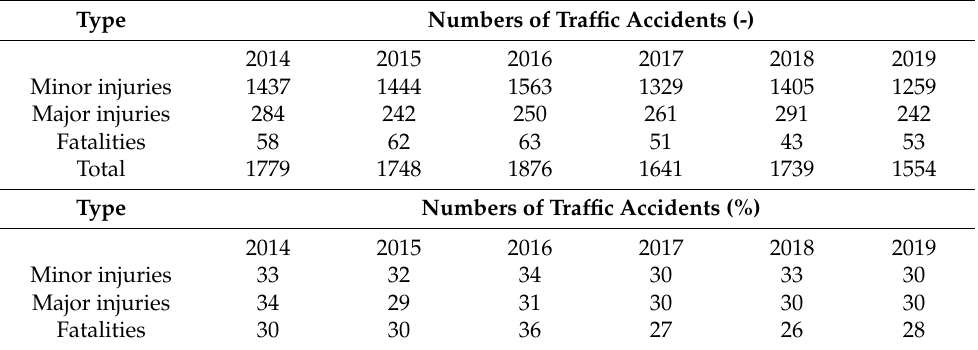
Table 1. Traffic accidents of new drivers (with less than 5 years of experience). Reprinted with